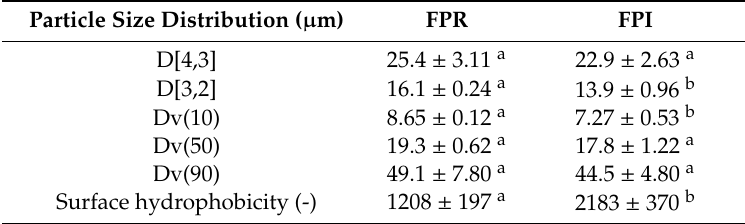
Table 2. Particle size parameters and surface hydrophobicity for FPR and